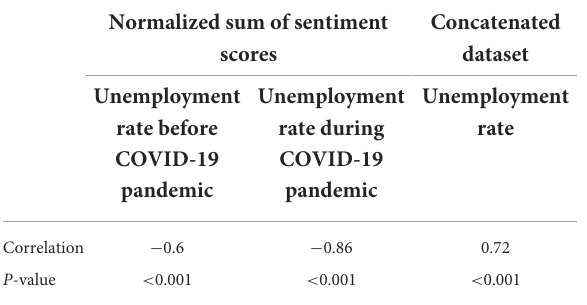
TABLE 2 The correlation between sentiment scores and the unemployment rate as well as that between the concatenated dataset and the unemployment rate.